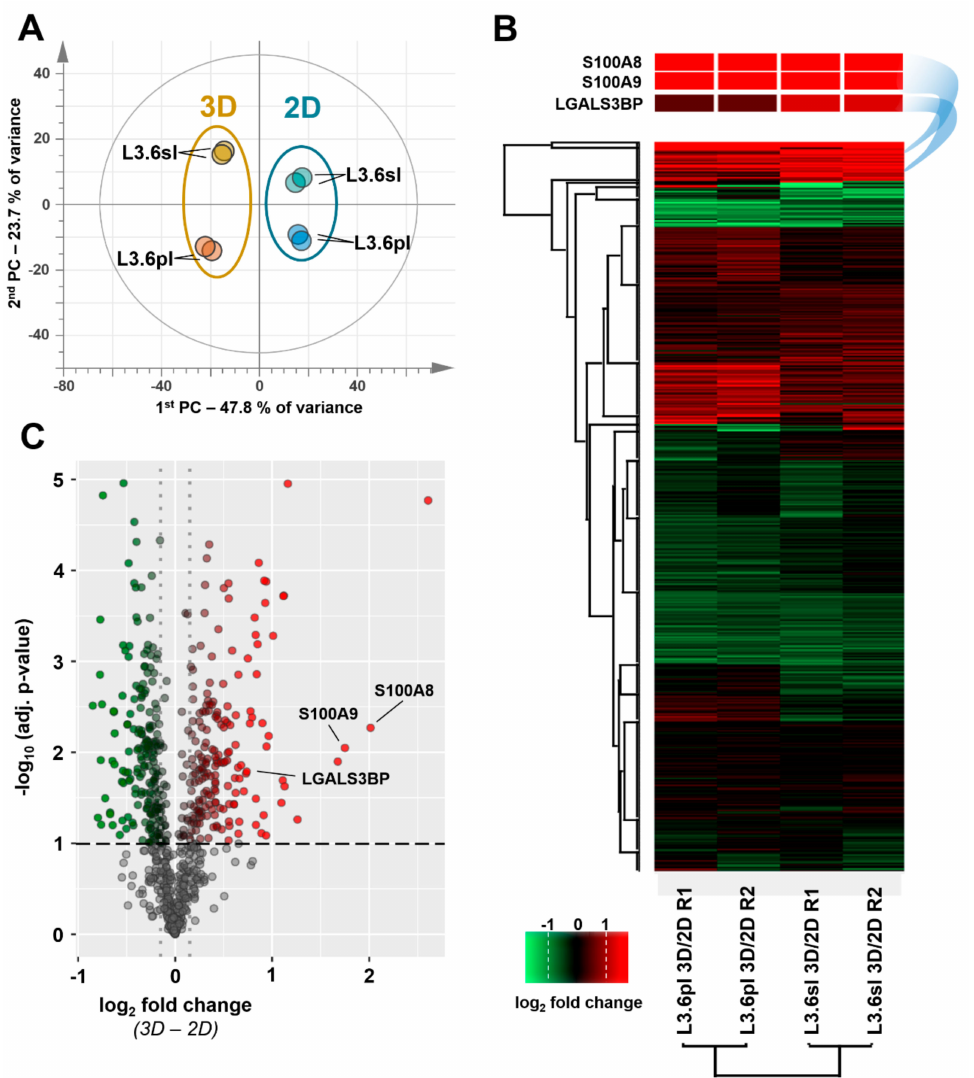
Figure 2. Principal component analysis (PCA) of the combined PTX dataset ( A ): Clusters of tumor-initiating cells (TICs) (3D) and non-TICs (2D) are indicated in orange and blue, respectively. Clustered heat map of log 2 -fold changes between TICs and non-TICs in L3.6sl and L3.6pl samples (green = downregulation, red = upregulation) ( B ). Proteins and samples, respectively, were grouped by means of hierarchical clustering. The top three rows show a magnified excerpt demonstrating the di ff erences in expression of S100A8, S100A9, and LGALS3BP. Volcano plot depicting log 2 -fold changes (3D vs 2D) plotted against the negative decadic logarithm of the adjusted p-value ( C ): Adjusted p-values were assessed by a paired t-test correcting for multiple comparison with Benjamini–Hochberg at an FDR of 10%. Four replicates each were considered for 3D and 2D cultured cells. Nonsignificantly altered proteins are situated below the horizontal dashed line (grey dots). Proteins being significantly regulated are marked by gradually increasing tinting strength of either green (downregulation) or red